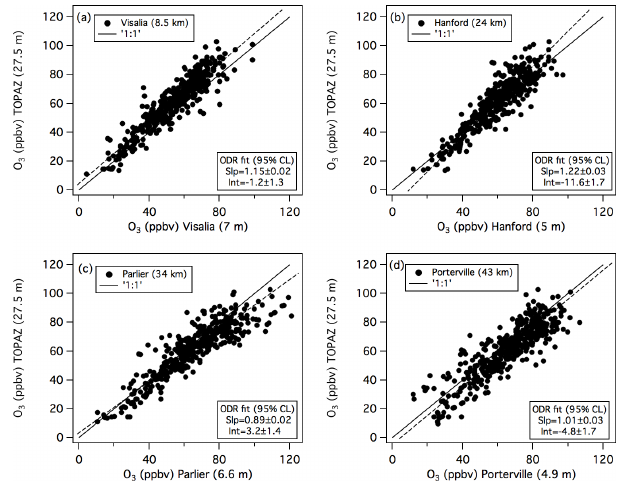
Figure 5. Scatterplots with ODR fits comparing the 27.5m TOPAZ measurements with the 1h measurements from the regulatory mon- itors at (a) Visalia–N. Church Street, (b) Hanford, (c) Parlier, and (d) Porterville. The measurements in the upper box and x axis la- bel refer to the distance from the VMA and sampling height above ground, respectively. The Visalia monitor is operated by the Cali- fornia Air Resources Board. The remaining three are operated by CARB and the SJVAPCD. The TOPAZ measurements are interpo- lated to the 1h time base of the regulatory measurements for the